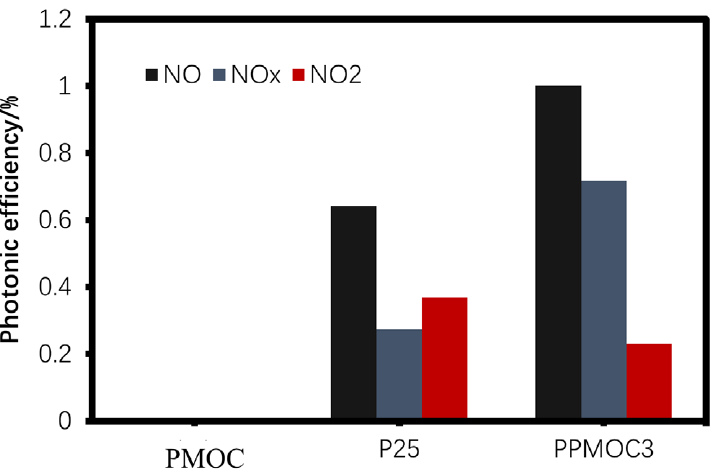
Figure 4. Photonic efficiency (ξ) of the NO 2 generation and the removal of NO and NO x for PMOC, P25, and PPMOC3. (PMOC - porous magnesium oxychloride cement; P25 - TiO 2 with an average particle size of 25 μ m; PPMOC3 - photocatalytic porous magnesium oxychloride cement with different porosity).